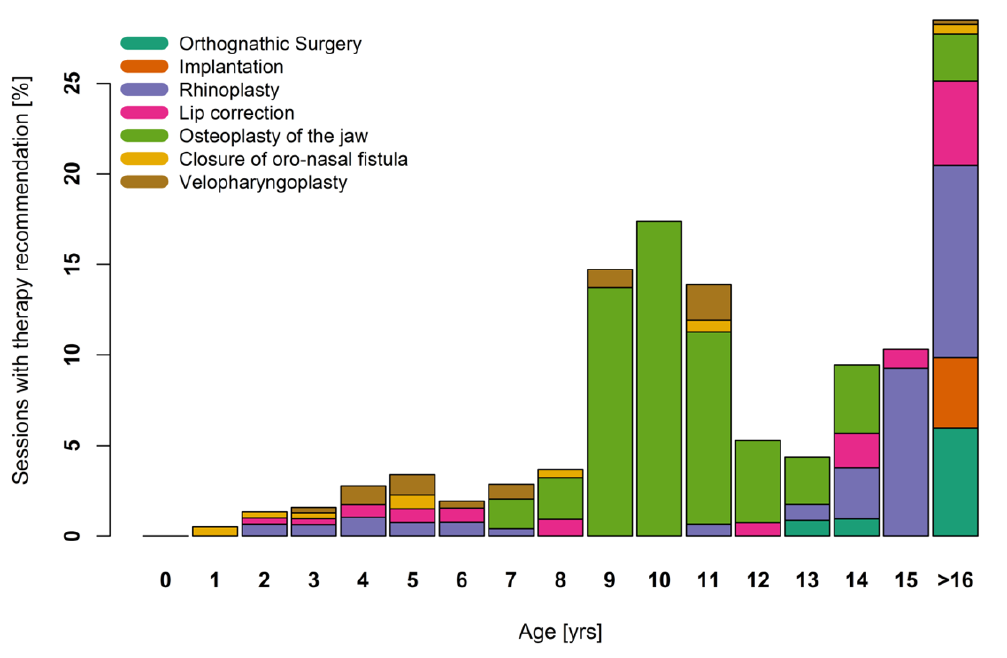
Figure 4. Proportion of different types of surgical therapeutic interventions per age.